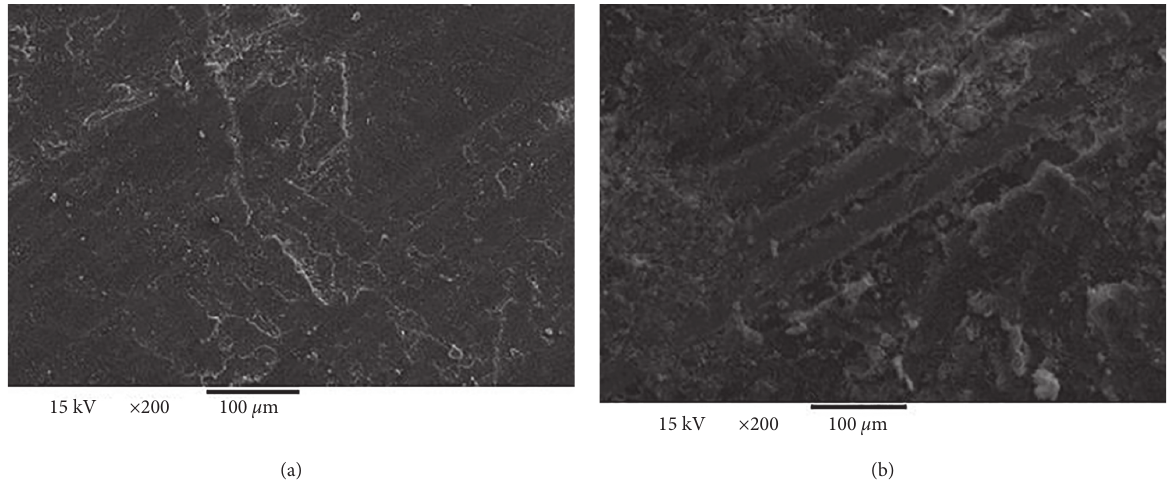
Figure 20: Electron microscope of the specimens after grinding. (a) Electron microscope of the specimen after the manual grinding process. (b) Electron microscope of the specimen after sandblasting